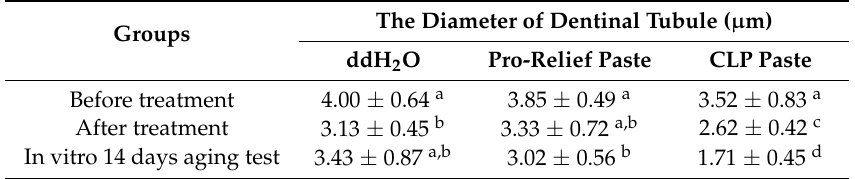
Figure 2. The optical micrographs of occlusal dentin disk surface pre-treatment, immediately post-treatment, and 14 days post-treatment of various desensitizing pastes. Table 1. Means of dentinal tubule diameter with various treatments and time periods.